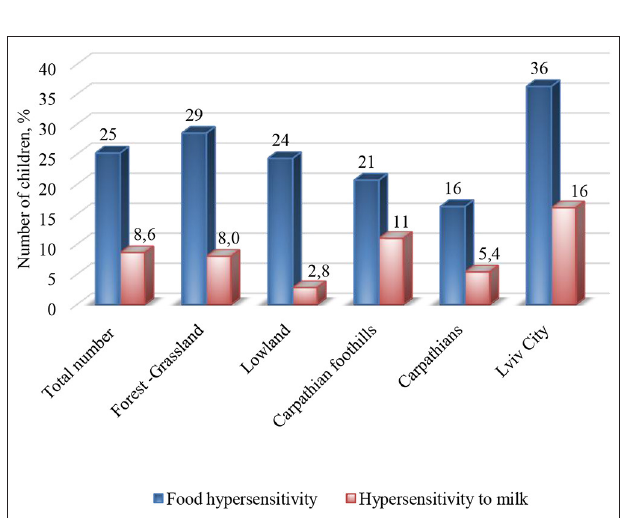
FIGURE 3 | Distribution of food and milk hypersensitivity in different geographic and climate zones of the Lviv region.